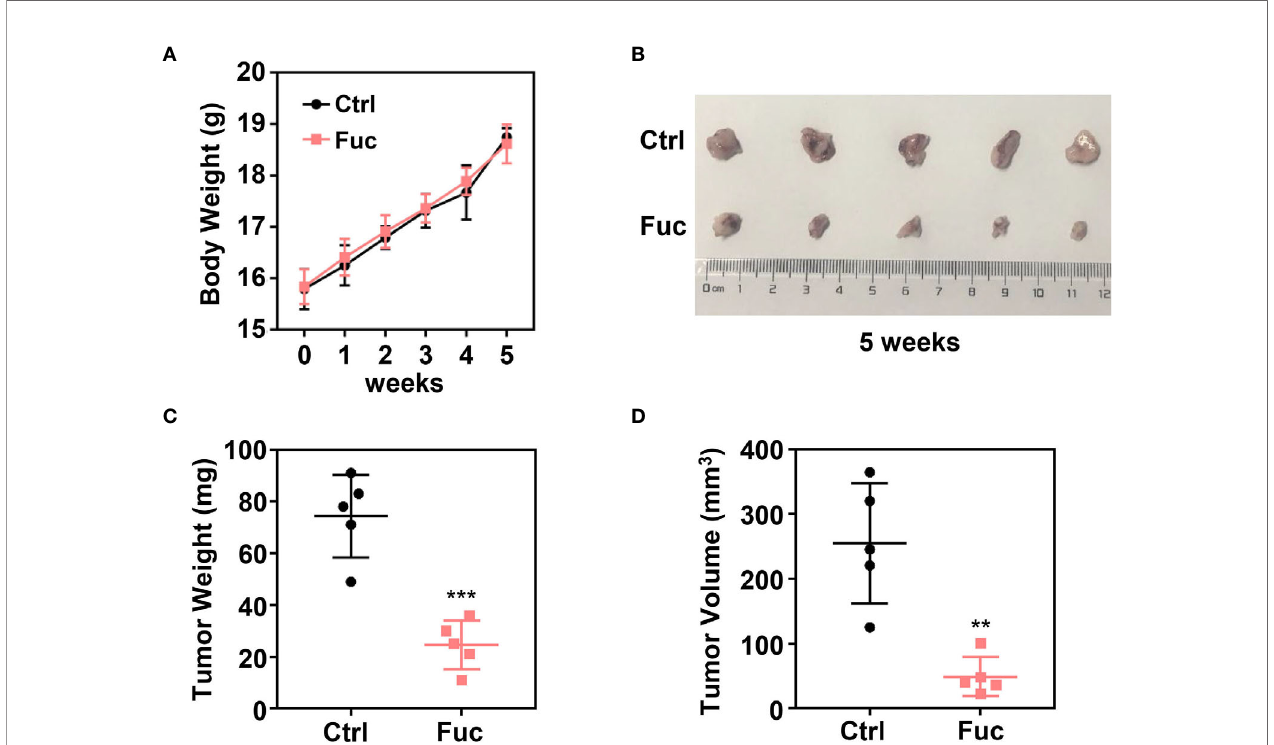
FIGURE 2 | Fucoidan inhibits proliferation of hepatocellular carcinoma in vivo . (A) Body weight of the Ctrl group and Fuc group (15 mg/kg Fuc per day, dissolved in saline). (B) Xenograft tumor formation of the Ctrl group and Fuc group. (C) Tumor weight of the Ctrl group and Fuc group. *** means P < 0.001. (D) Tumor volume of the Ctrl group and Fuc group. ** means P < 0.01.